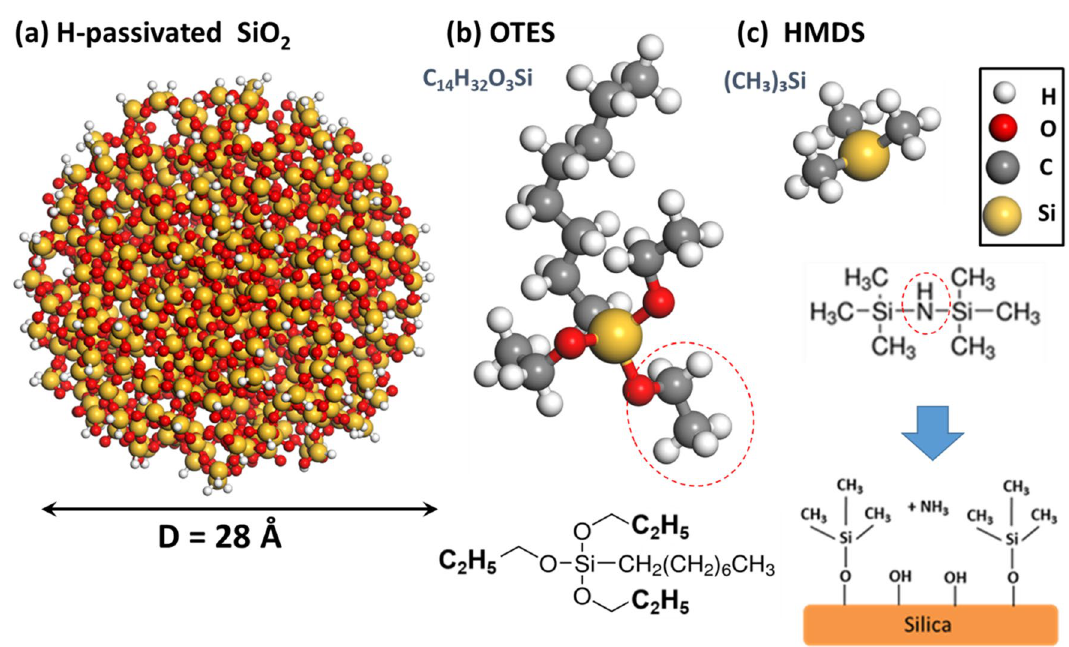
Figure 2. The atomistic model of hydrogen passivated SiO 2 nanoparticle ( a ) The atomistic models and structural formulas of OTES ( b ) and HMDS ( c ) functional molecules. An ethyl C 2 H 5 end-group can be released as an ethane C 2 H 6 molecule during chemical functionalization outlined by red dashed line. During the chemical functionalization, HMDS splits, producing the chemically grafted surface of silica and ammonia 77 . Hydrogen atoms are white, carbon atoms are grey, oxygen atoms are red, and silicon atoms are yellow. The BIOVIA Materials Studio 2020 VERNO 20.1.0.2728 (https:// www. 3ds. com/ produ cts- servi ces/ biovia/ produ cts/ molec ular- model ing- simul ation/ biovia- mater ials- studio) was used to create the drawings in the